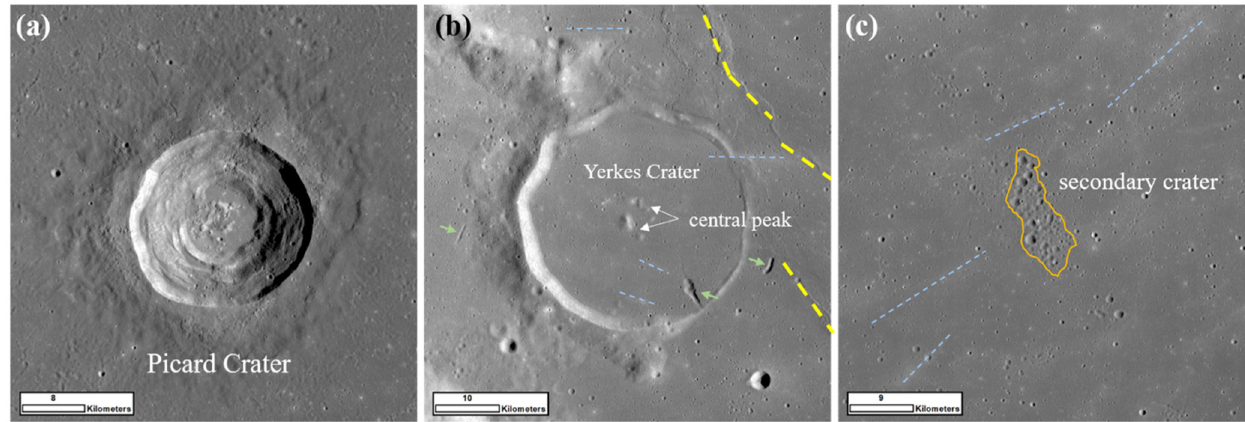
Figure 3. Typical impact craters in the Crisium basin. ( a ) The largest impact crater (~24 km in diameter) in this region: Picard Crater. ( b ) Yerkes Crater is a pre-mare crater with multiple central peaks. The wall and rim of Yerkes Crater remain intact, and the floor was filled with subsequent mare basalts. Two volcanic vents (green arrow) are identified near Yerkes Crater. ( c ) Secondary crater clusters are outlined by orange line. The sky-blue dashed lines show the ejecta from Proclus crater; wrinkle ridges near craters were also denoted using yellow dashed